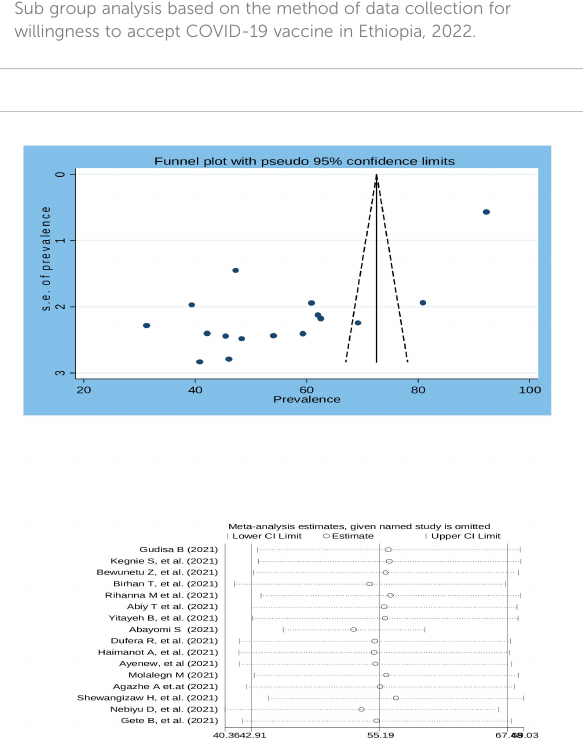
FIGURE 2 Forest plot for pooled willingness to accept COVID-19 vaccine in Ethiopia.